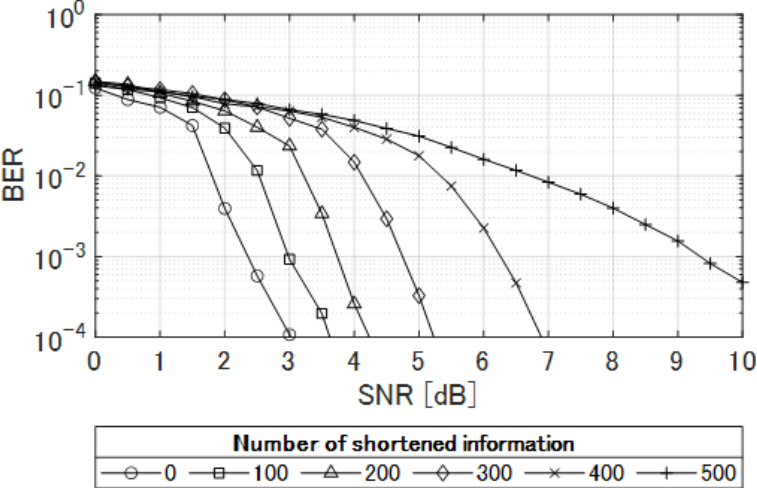
Figure 8. Bit error ratio (BER) characteristics of the cyberterrorist whose shortened information is unknown under the additive white Gaussian noise (AWGN) channel. The shortened information length m using distance information is varied from 0 to 500.